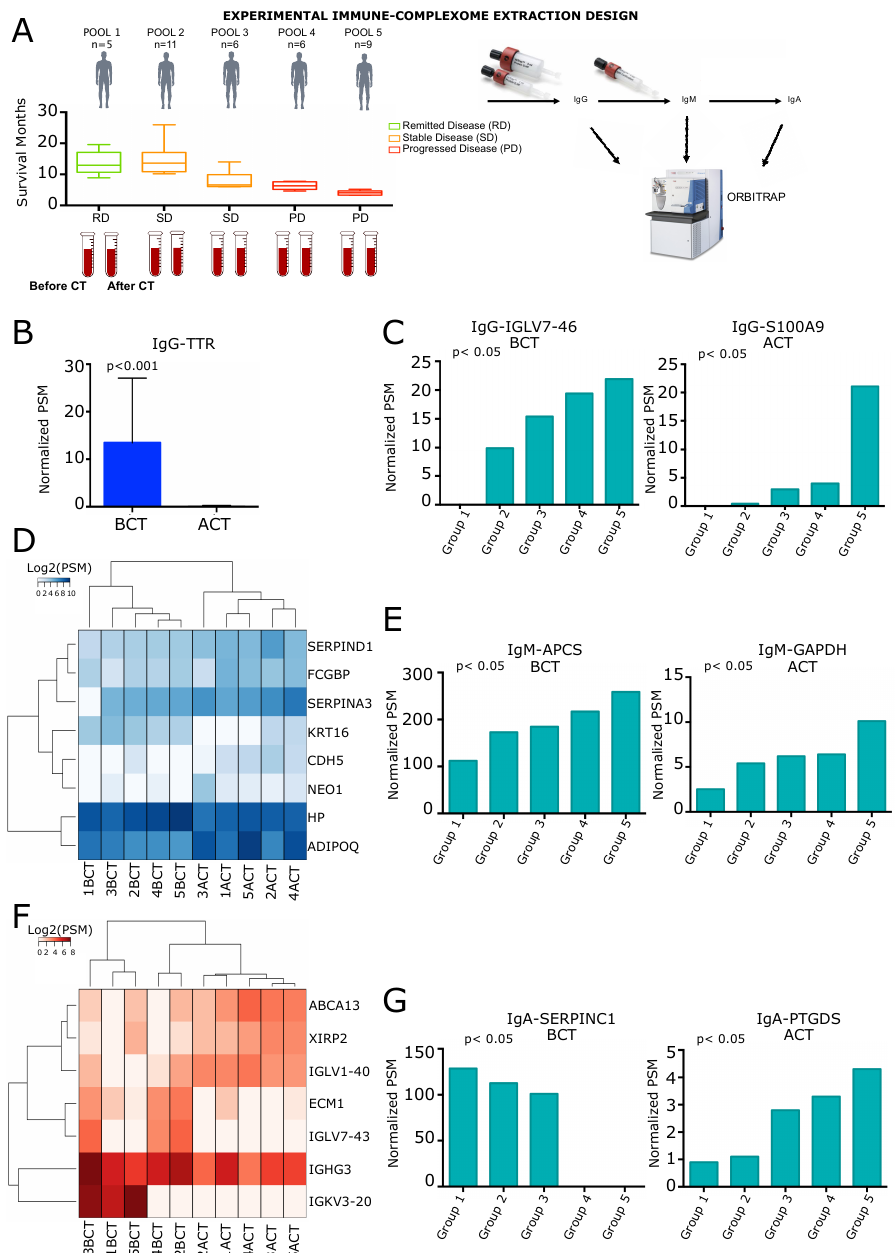
Figure 1. Analyses of IgG, IgM, and IgA immuno-complexes upon chemotherapy (CT) in sera of PDA patients. ( A ) scheme of the experimental design of the immune-complexome proteomic analysis using pulled sera from PDA patients collected before and after CT (BCT and ACT). Samples were divided into pools based on the months of disease-free survival; ( B ) Bar plot representing the circulating level of TTR (IgG differential associated antigen (DAA)) BCT and ACT; ( C ) bar plots representing the most significant trends of IgG Circulating Immune Complexes (CIC) considering BCT and ACT results separately. Both IgG-IGLV7-46 (left panel) and IgG-S100A9 (right panel) increased from good to bad prognosis in the five groups; ( D ) heat map showing IgM DAA in the five groups of patients; ( E ) bar plots representing the most significant trends of IgM CIC considering BCT and ACT results separately. Both IgM-APCS (left panel) and IgM-GAPDH (right panel) increased from good to bad prognosis in the five groups; ( F ) heat map showing IgA DAA in the five groups of patients; ( G ) bar plots representing the most significant trends of IgA CIC considering BCT and ACT results separately. IgA-SERPINC1 (left panel) decreased from good to bad prognosis and IgA-PTGDS (right panel) increased from good to bad prognosis in the five groups. All CIC are represented as number of Peptide-Spectrum Matches